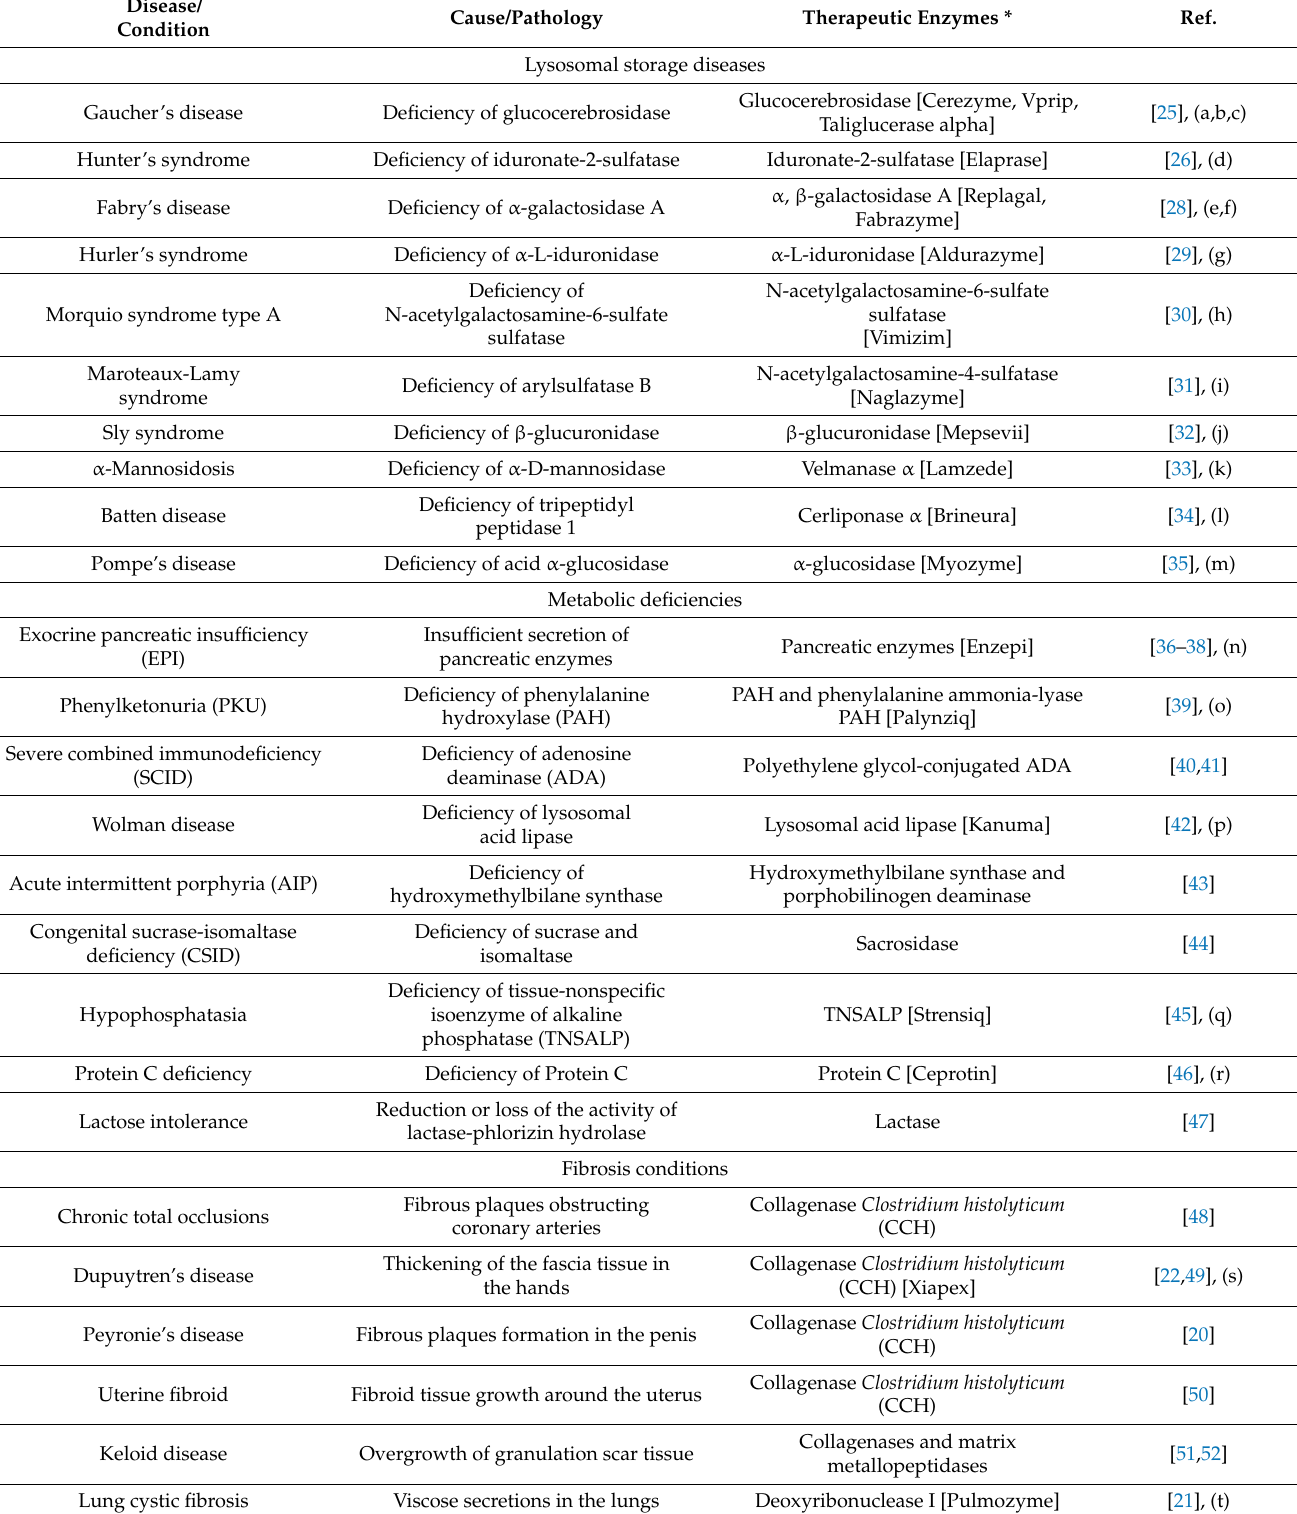
Table 1. Summary of the main pathologies and conditions treated with